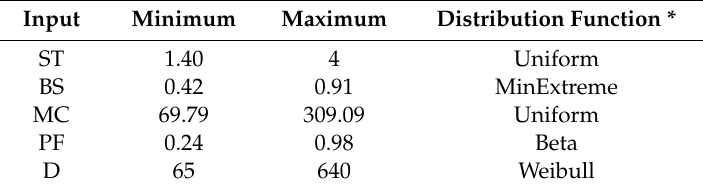
Figure 6. Steps of application of Monte Carlo simulation in PPV risk analysis. Table 4. Distribution function of the inputs used in MC simulation.